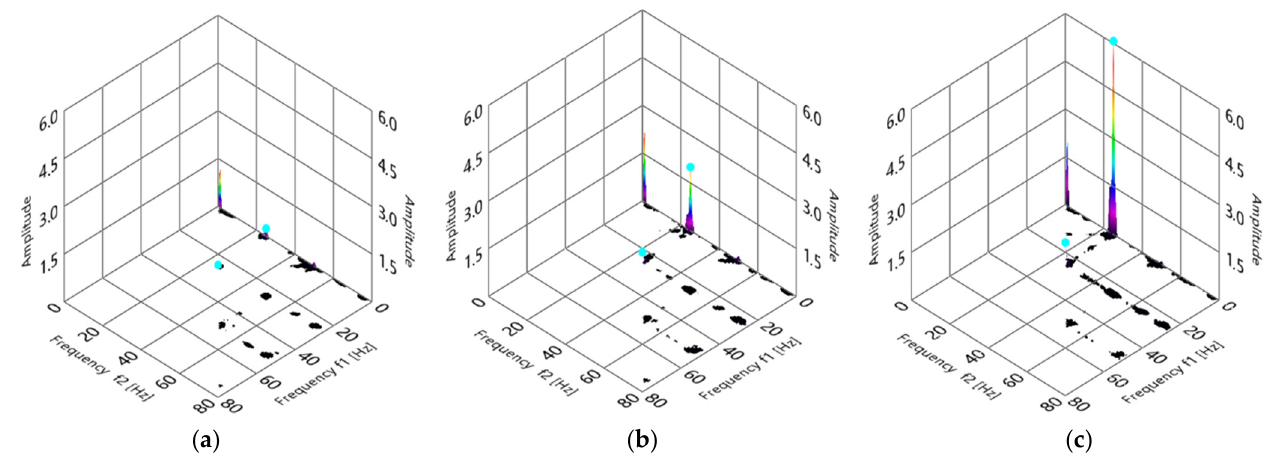
Figure 9. Mechanical vibration BS spectra for a rotational speed of n 6 = 1500 rpm with unbalance mass changes: balanced drive ( a ); m 1 = 1.07 g ( b ); m 5 = 2.36 g ( c ) (amplitude should be multiplied by 10 − 6 ).